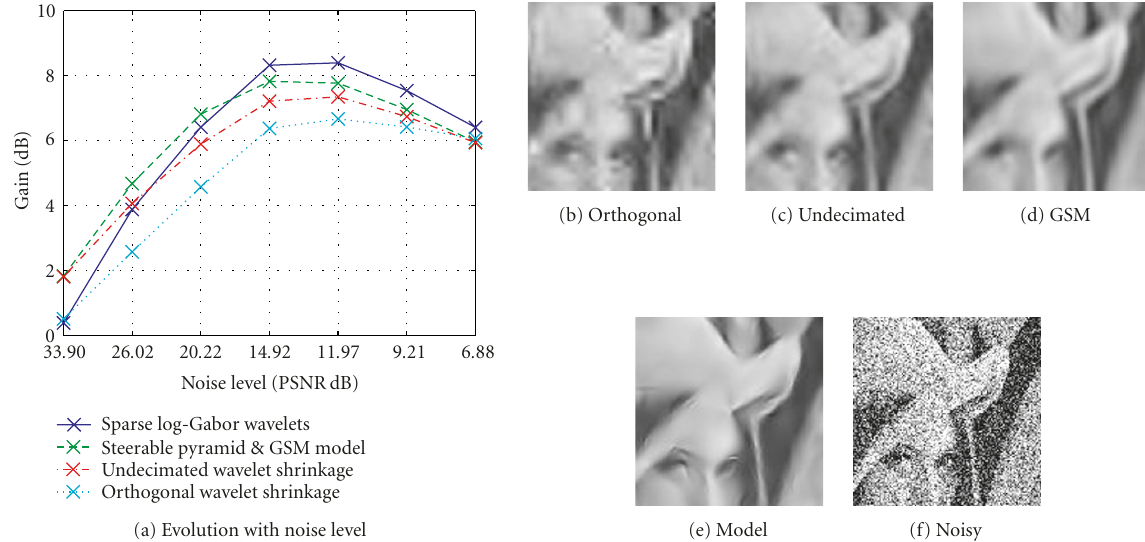
Figure 14: Denoising results at di ff erent noise levels. (a) The evolution of the denoising results is plotted for Lena (original in Figure 13) as the gain (i.e., the improvement in terms of PSNR), as a function of the noise level (also measured as PSNR). For low noise levels (33 . 90 and 26 . 02 dB), the model yields poorer gain than the other methods. This could be due to the imperfect reconstruction o ff ered by the sparse approximation method. For high noise level (PSNR lower than 15 dB), the model o ff ers a higher gain than the other methods. Bottom insets show denoising results using (b) orthogonal wavelets, (c) undecimated wavelets, (d) the GSM model, and (e) the present model on a noisy version of “Lena” (f) which PSNR is 11 . 97